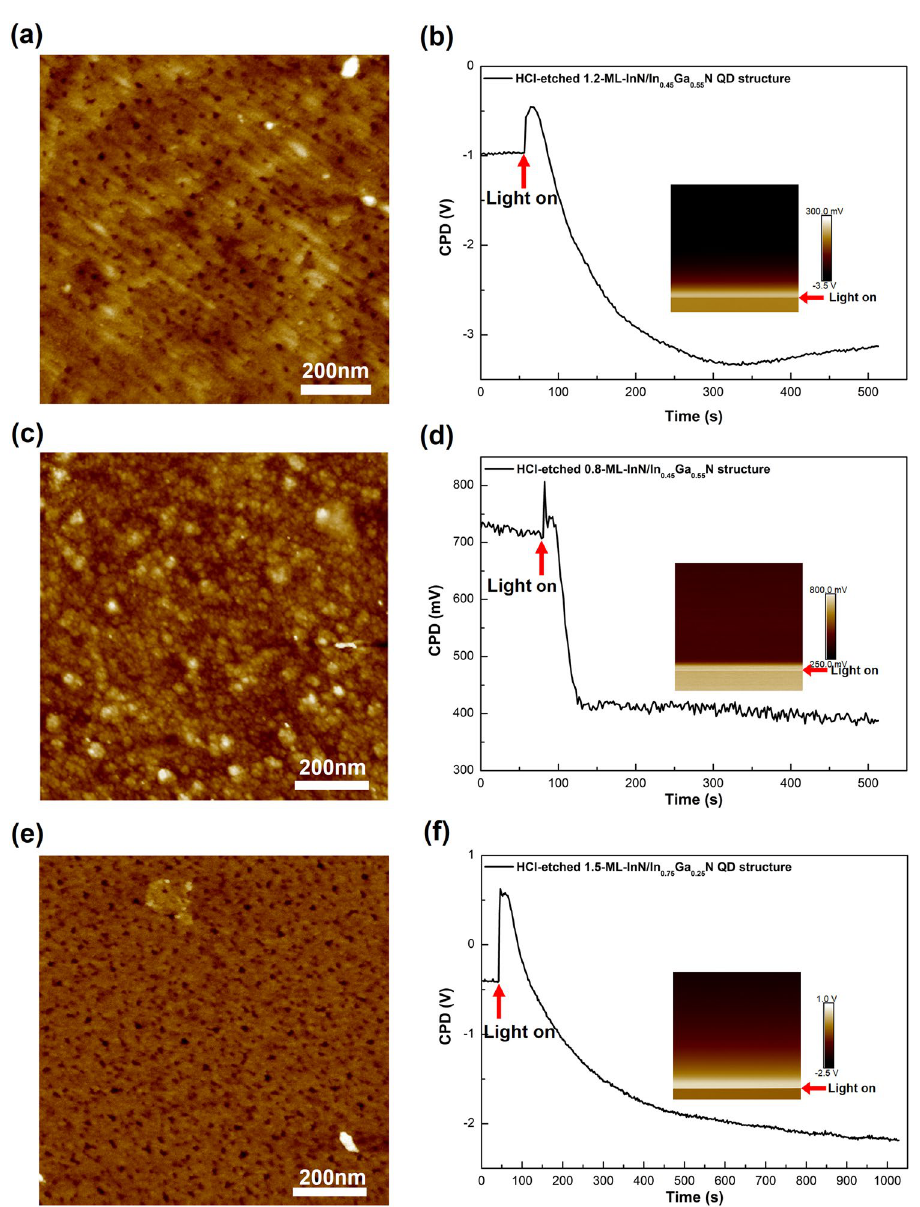
Figure 2. HCl-etched InN/InGaN structures. AFM height images and CPD as a function of time after HCl- etching for the ( a , b ) 1.2-ML-InN/In 0.45 Ga 0.55 N QD structure, ( c , d ) 0.8-ML-InN/In 0.45 Ga 0.55 N structure and ( e , f ) 1.5-ML-InN/In 0.75 Ga 0.25 N QD structure. Insets in ( b , d , f ): KPFM CPD images. The arrows indicate the switching on of the light. The scan field is 1 × 1 µ m 2 and the full height contrast is10 nm in all AFM